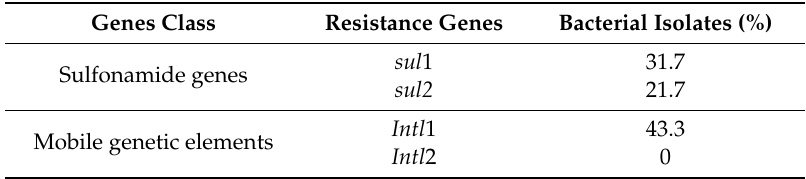
Table 5. Prevalence of Sulfonamide Resistance Genes and Mobile Genetic Elements in Bacterial Isolates